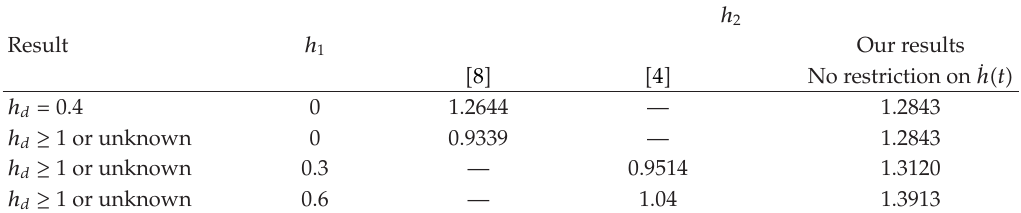
Table 1: Maximum allowable upper bounds h 2 of the time-varying delay for di ff erent values of the lower bounds h 1 in example 1 of (cid:4) 8 (cid:5) .